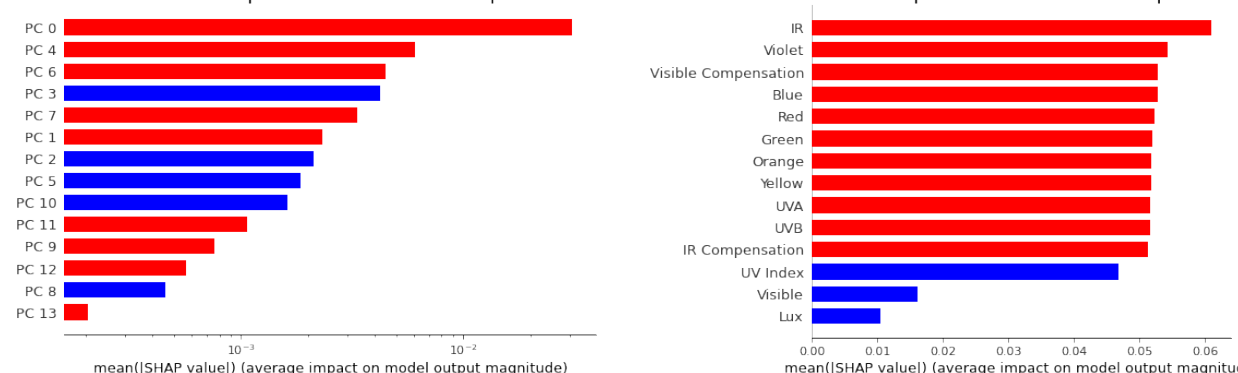
Figure 9. ( Left ) PCA feature importance of our MLP model for whole spectrum calibration; we used a log 10 scale in the x direction. ( Right ) The original feature importances from the linearly splitting of the 0th principle component’s SHAP values. A feature with red (blue) color has positive (negative) impact on the model’s